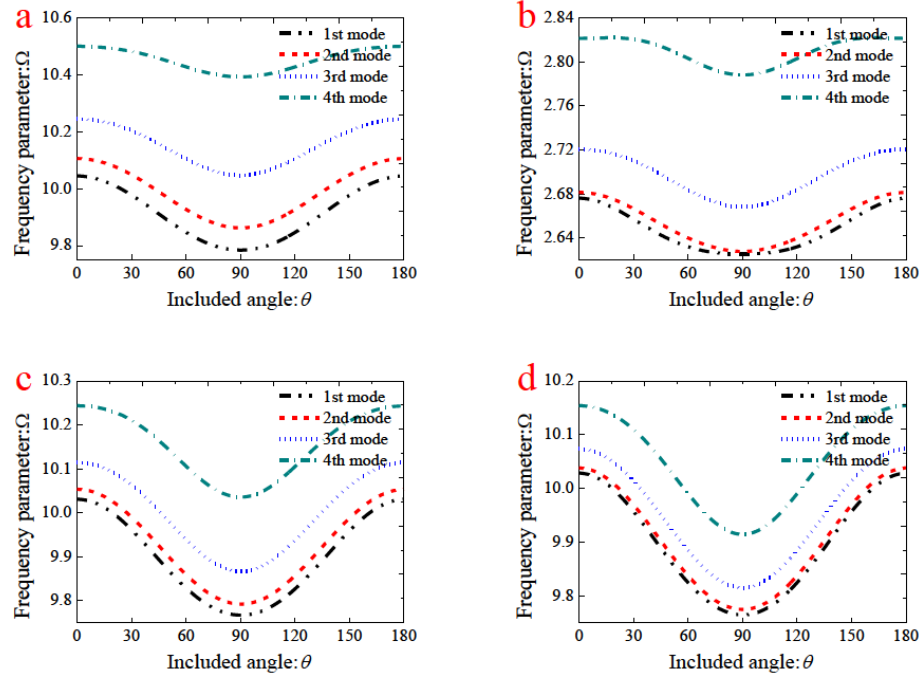
Figure 8: Variation of the frequency parameters Ω versus the included angle θ for a three-layered [0 o / θ o /0 ∘ ] laminated annular sector plate with different boundary conditions: (a) CCCC; (b) CFFF; (c) CSCF; and (d)